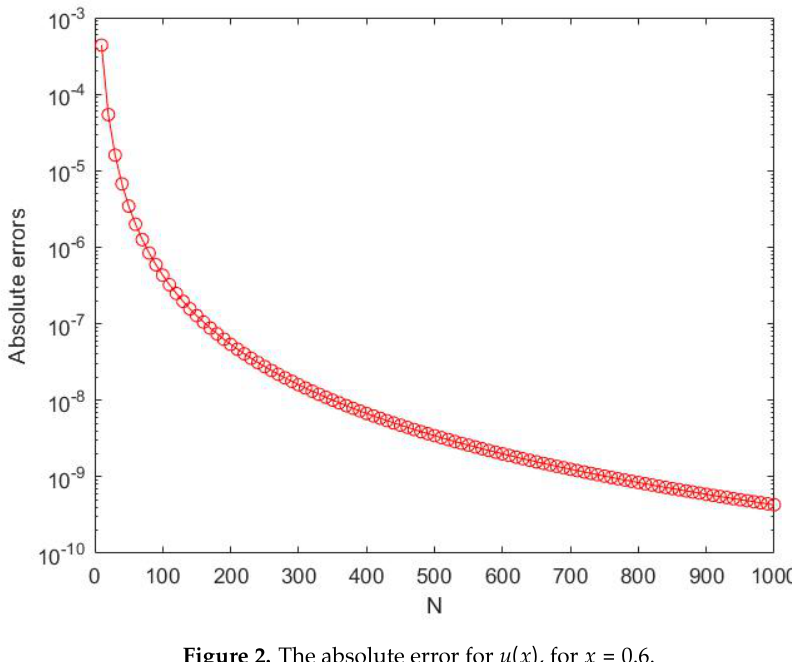
Figure 2. The absolute error for u ( x ) , for x = 0.6.